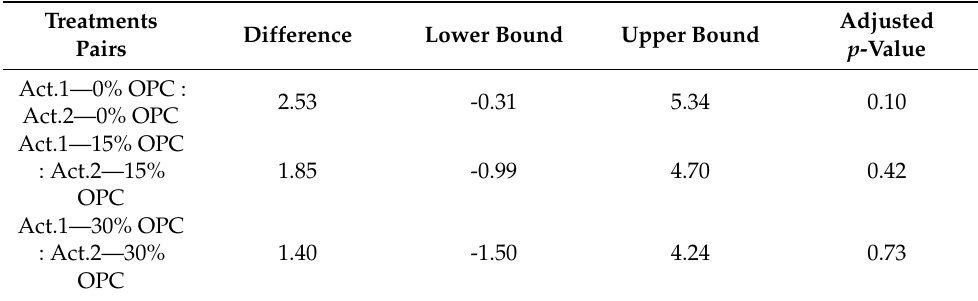
Table 5. Tukey ´ s method results between Act.1 and Act.2. with their respective OPC levels. C.I.